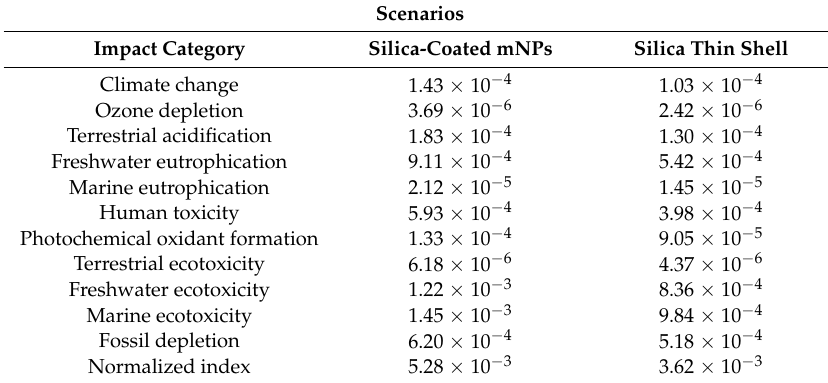
Table 4. Normalized environmental impacts associated with the production of silica-coated mNPs (FeO-2206W) and silica thin shell per g of